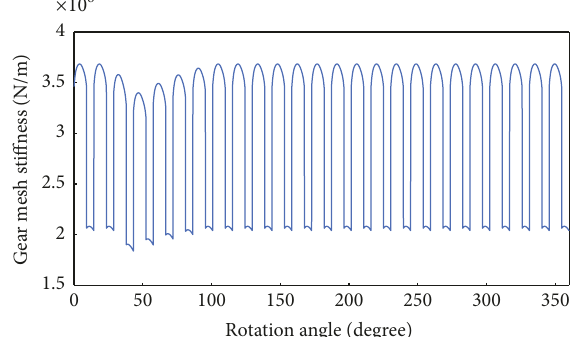
Figure 17: The gear mesh stiffness for the second scenario (two con- secutive cracked teeth with 30% CLP).